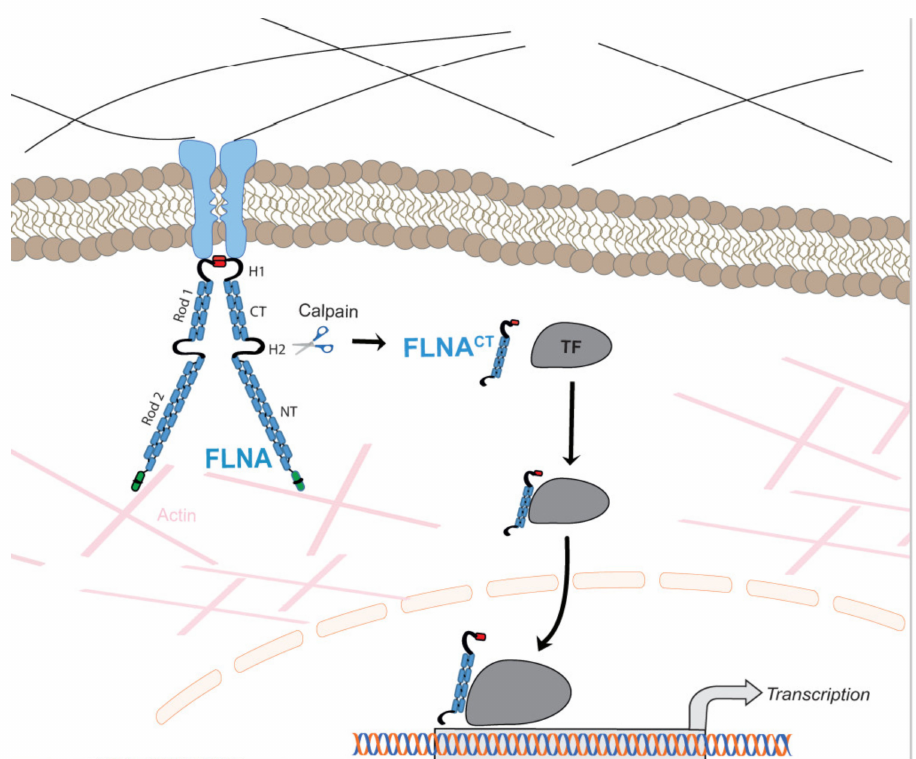
Figure 1. Schematic illustration of the regulation of function of transcriptional factors (TF) by FLNA. Membrane-bound FLNA mediates extracellular signals to the cytoskeleton. FLNA interacts with multiple TF in a cell-specific manner in the cytoplasm. Increased calpain protease activity cleaves membrane-bound FLNA releasing the FLNA CT , which is translocated to the nucleus together with TF. As part of the transcriptional complex, FLNA CT can also bind to promoter regions of target genes. Thus, FLNA CT increases the transactivation function by facilitating translocation to the nucleus and/or nuclear retention and/or by working as a transcriptional